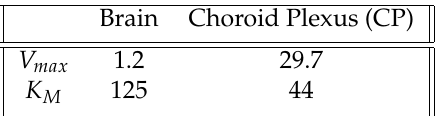
Table 2. V max and K M Estimations for Brain and